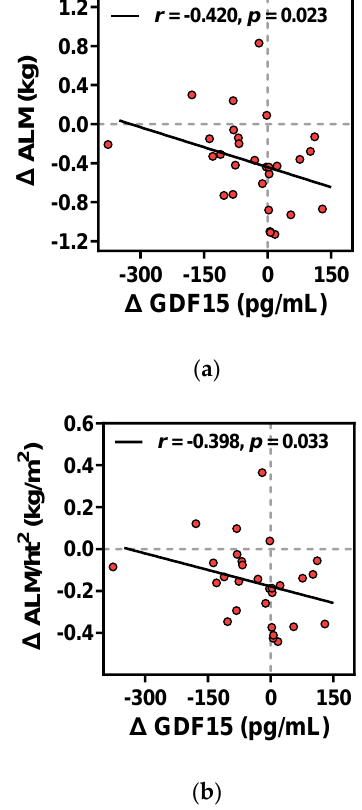
Figure 6. Correlations of Δ GDF15 level with ( a ) Δ appendicular lean mass (ALM) glucose and ( b ) Δ ALM to height ratio (ALM/ht2) before and after the intervention. Correlation coefficient (r), corresponding regression and 95% CI lines, and p -values are represented in the respective panels. Red-filled circles are individual values.